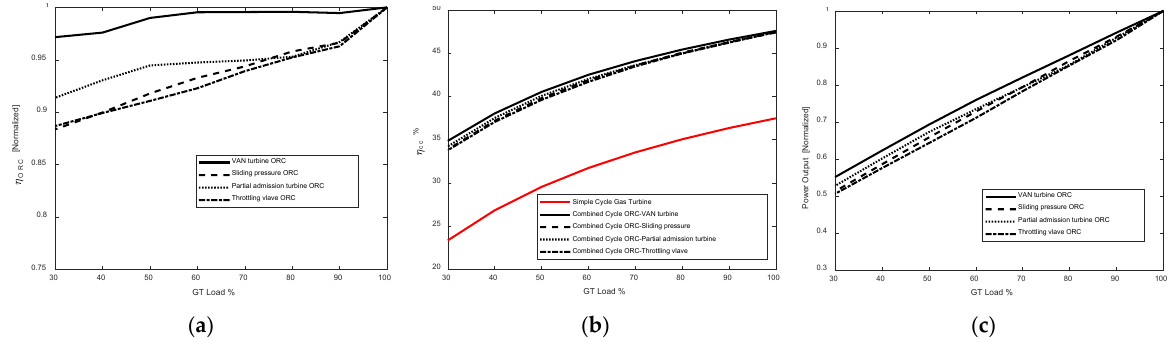
Figure 11. Part-load performance case B: ( a ) ORC efficiency; ( b ) Combined cycle efficiency; ( c ) ORC power output.